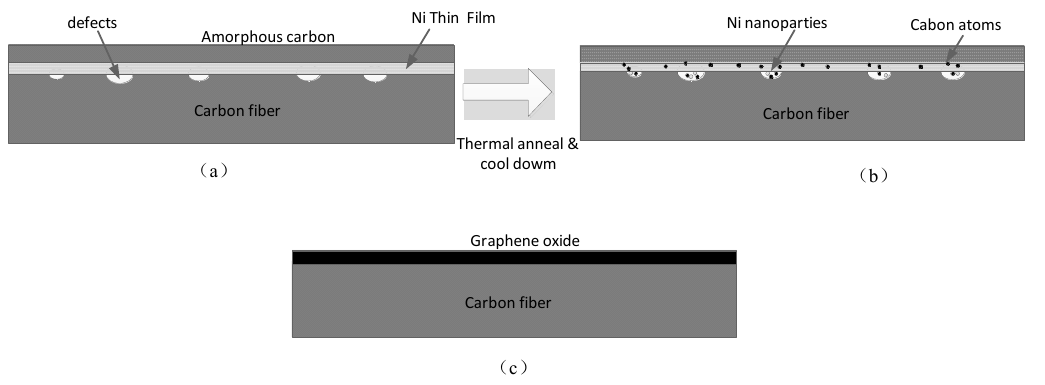
Figure 1. Schematics of the defect repair process of carbon fiber (CF). ( a ) Schematic of nickel and amorphous carbon deposited on defective fiber; ( b ) Graphene oxide (GO) forming process during thermal treatment; ( c ) schematic of CF after thermal anneal.